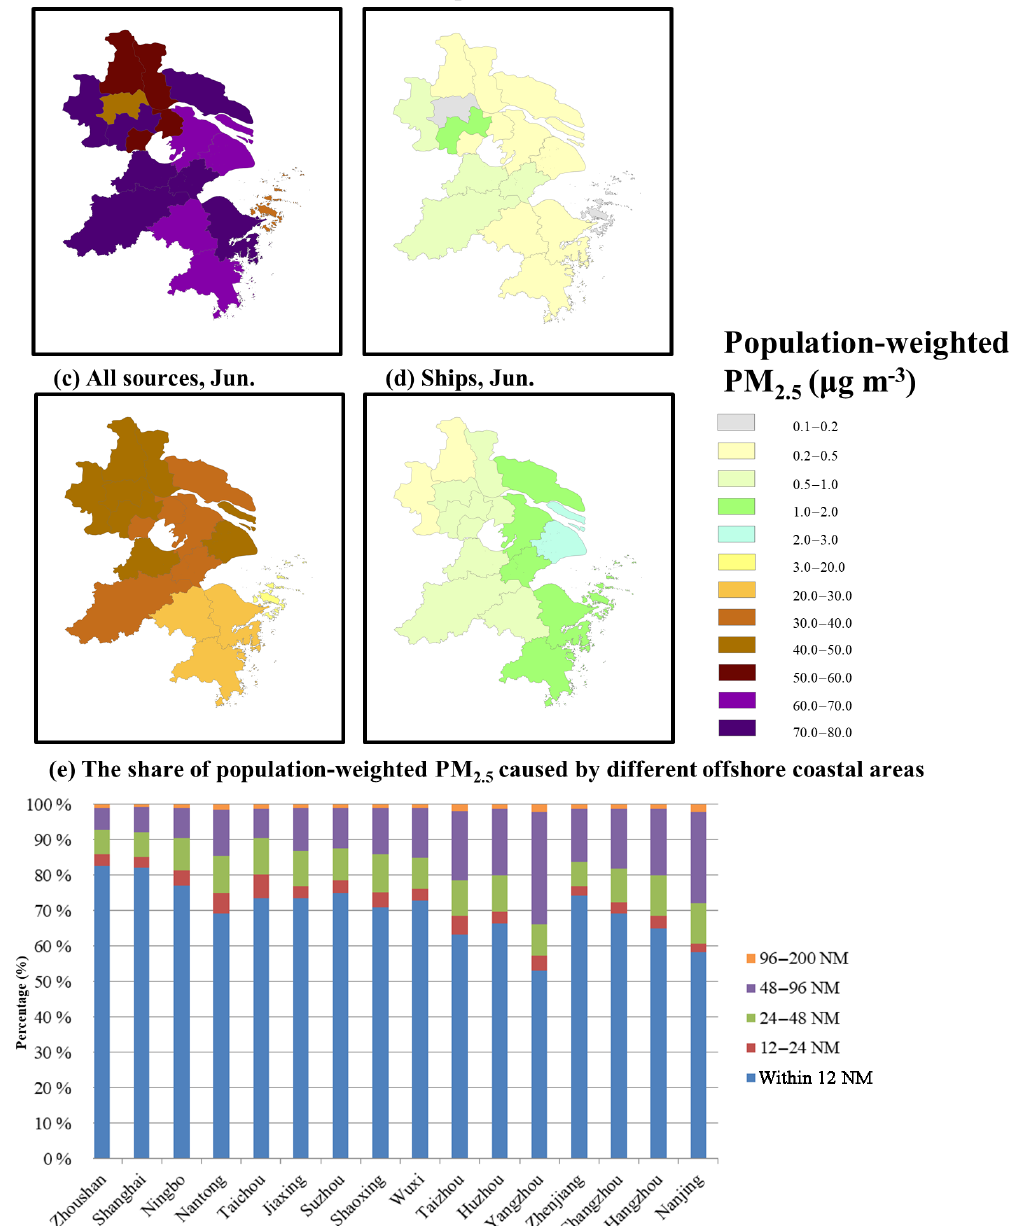
Figure 7. The spatial distribution of population-weighted PM 2 . 5 in 16 YRD cities caused by all pollution sources (a, c) and by all ships (b, d) in January 2015 (a, b) and June 2015 (c, d) ; the average share of population-weighted PM 2 . 5 in 16 YRD cities caused by different offshore coastal areas in all ships (e) . The cities’ names are ordered by their distance from the